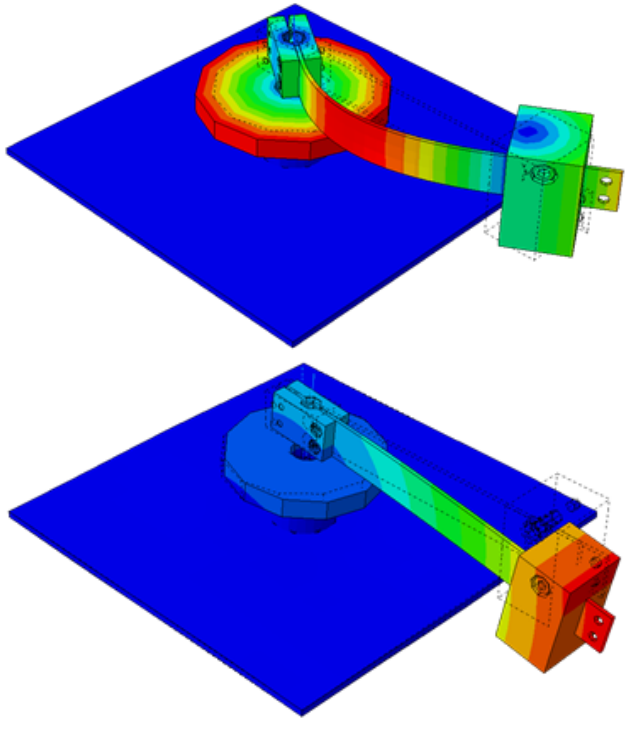
Figure 10. Illustration of mode shapes for eigenmode 2 ( top ) and 3 ( bottom